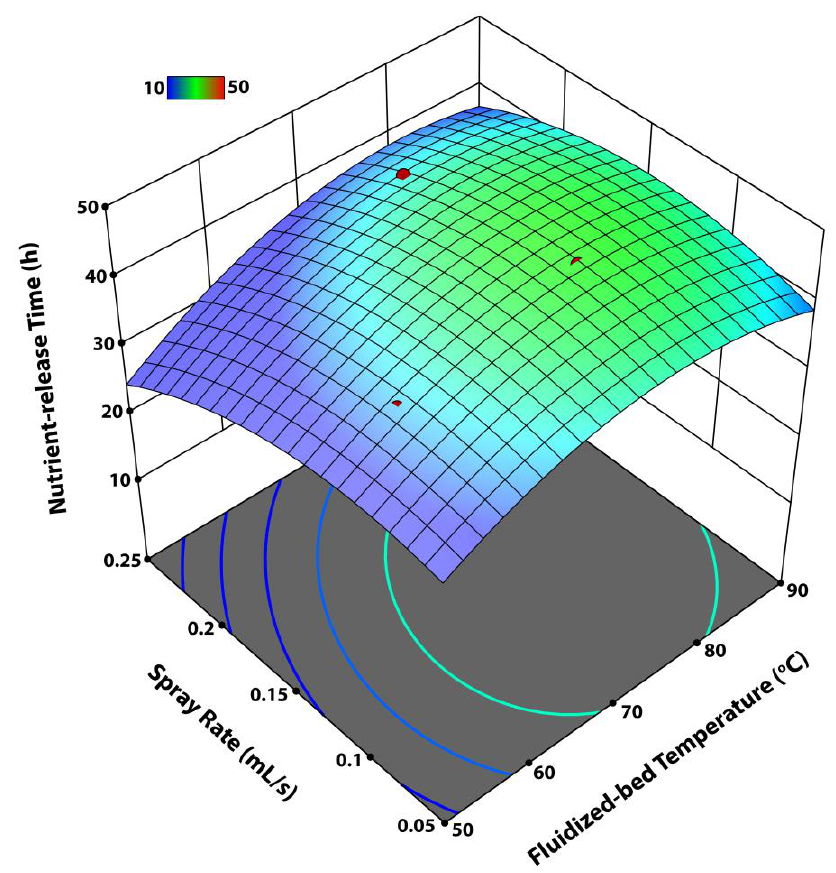
Figure 10. Interactive effect of the spray rate ( R spray ) and fluidized-bed temperature ( T fb ) on the nutrient-release time.